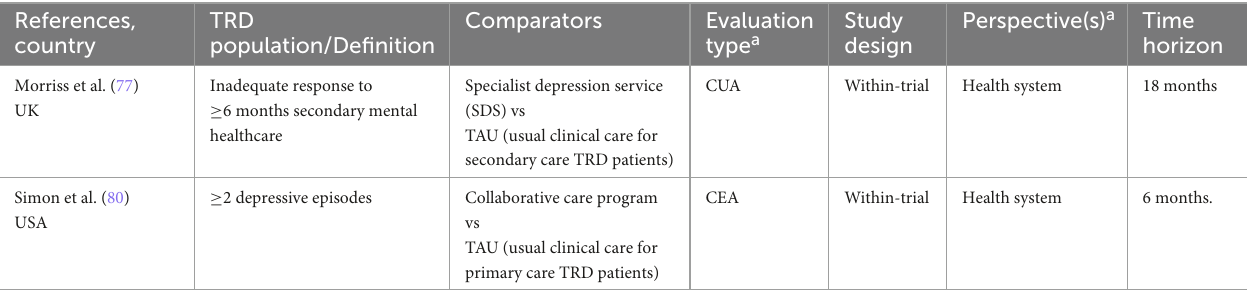
TABLE 2D Characteristics of economic evaluations of service-level